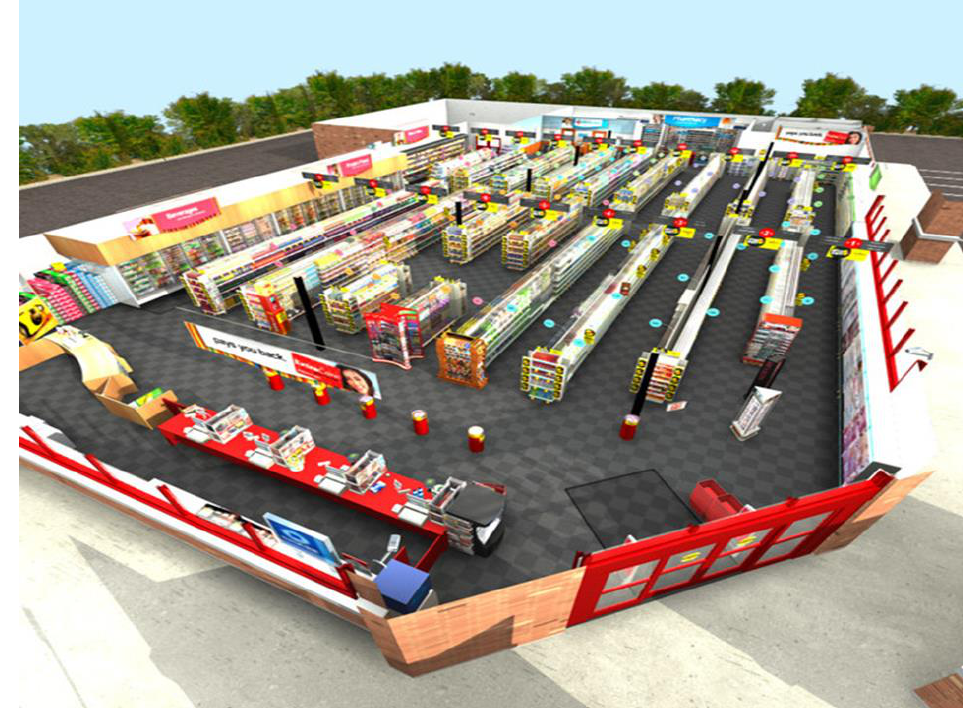
Figure 1. Virtual Environment Grocery